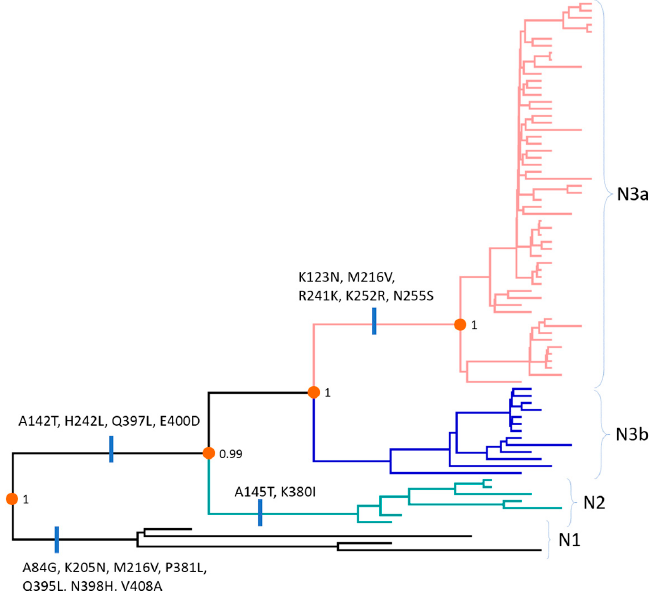
Figure 4. The maximum clade credibility tree based on the N gene with reconstructed nonsynonymous substitutions were mapped to the branches of the phylogeny. For clarity, posterior values were shown for main separating nodes .